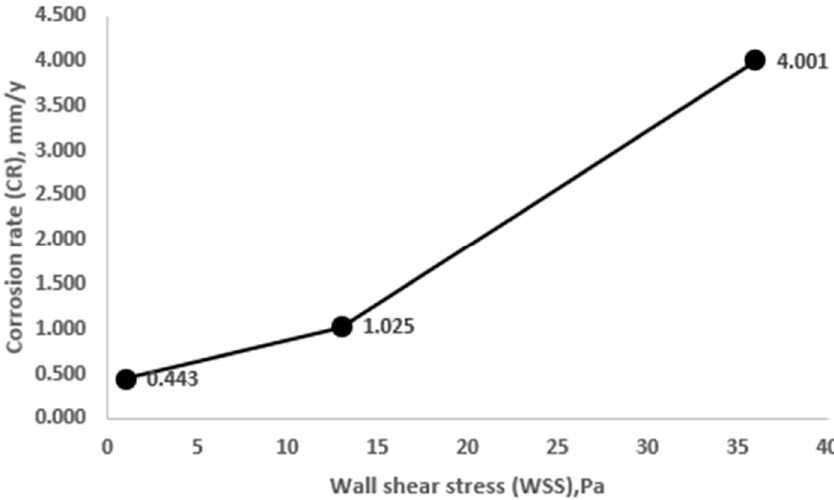
Figure 11. Influence of wall shear stress levels on the intensification of corrosion rate.